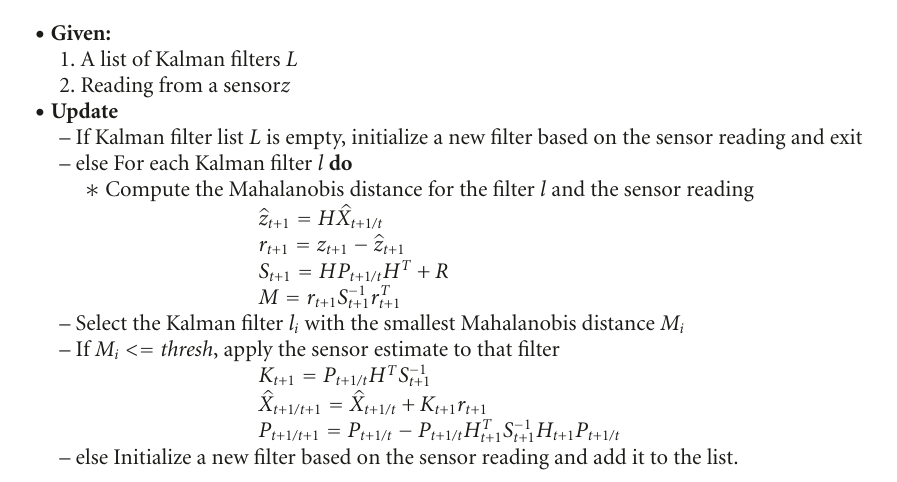
Algorithm 4: Multiple hypothesis state estimation sensor update